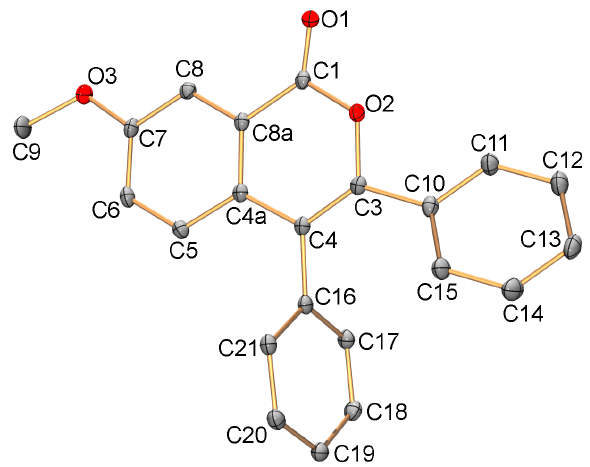
Figure 2. Structure of compound 3aa’ (one of two symmetry-independent molecules). Ellipsoids are shown at the 50% level. Hydrogen atoms are omitted for clarity. Selected bond lengths (Å) for the first/second symmetry-independent species are as follows: C1 − O1 1.208(2)/1.198(2), C1 − O2 1.371(2)/1.371(2), C3 − O2 1.384(2)/1.393(2), C7 − O3 1.363(2)/1.366(2), C1 − C8a 1.462(3)/1.472(3), C3 − C4 1.349(3)/1.352(3), C4 − C4a 1.457(3)/1.462(3), C4a − C8a 1.400(3)/1.403(3), C4a − C5 1.405(3)/1.403(3),